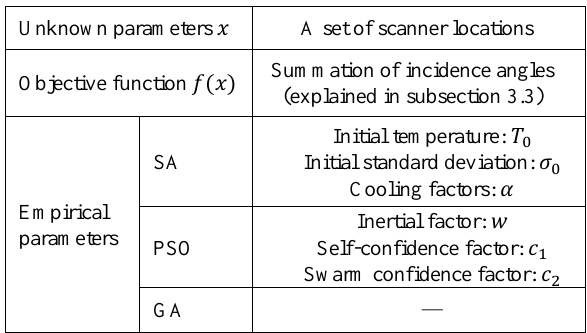
Table 1. Adopted parameters in the three heuristic methods